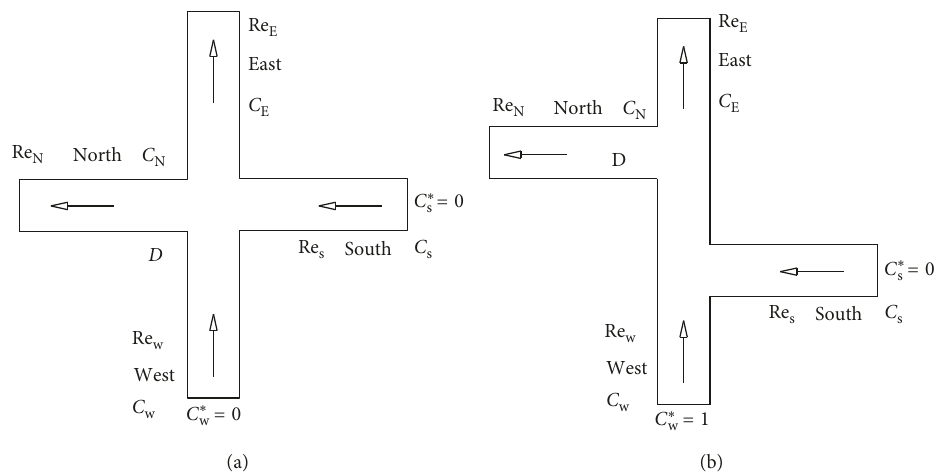
Figure 1: Hydraulic and water quality configurations of the junctions: (a) cross junction; (b) double-Tee